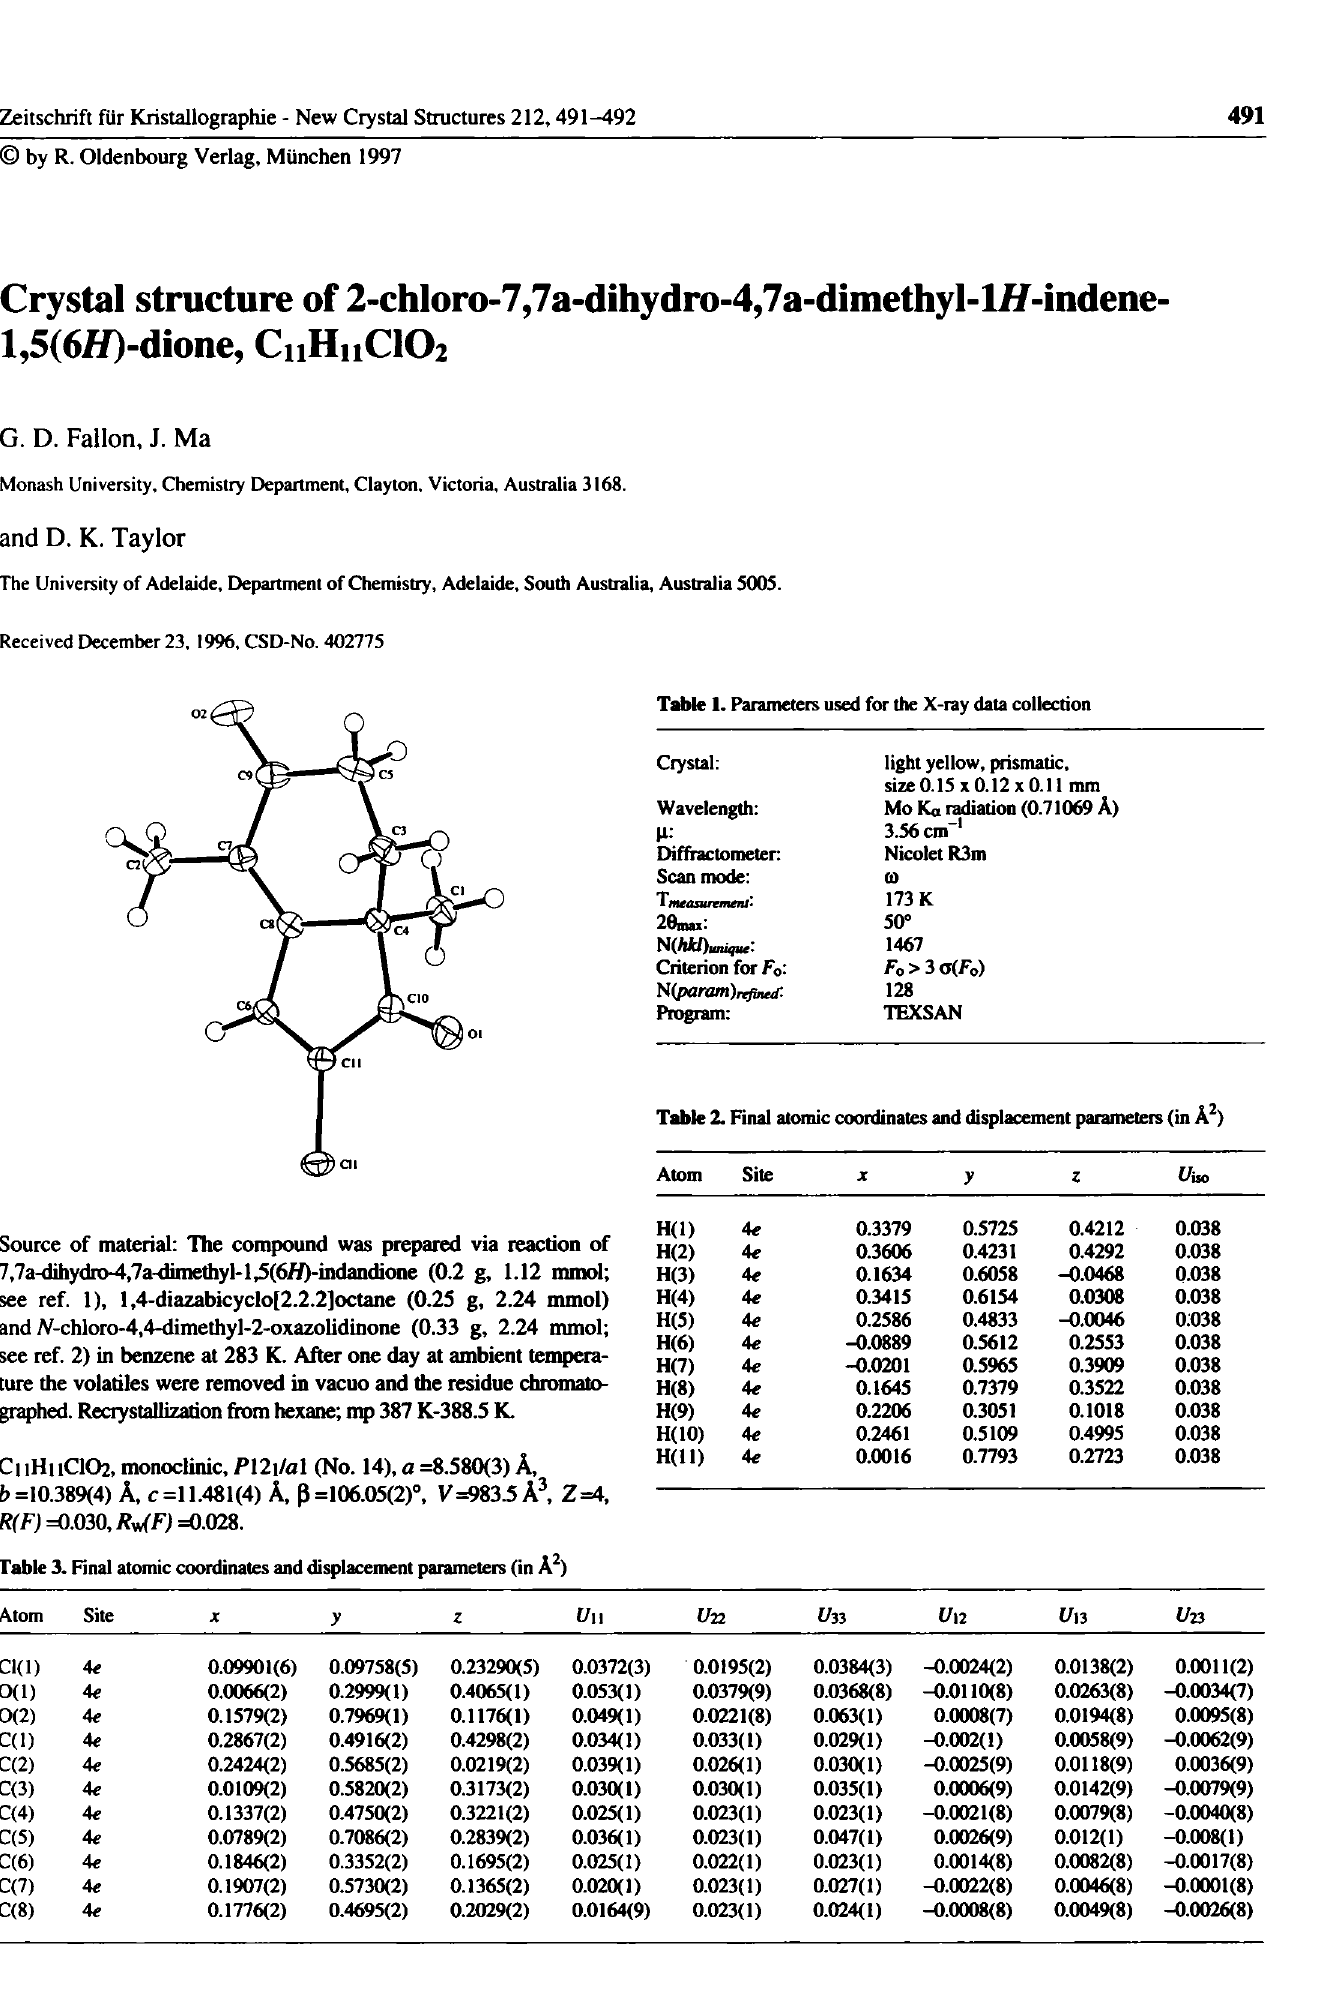
Table 3. Final atomic coordinates and displacement parameters (in À 2 )